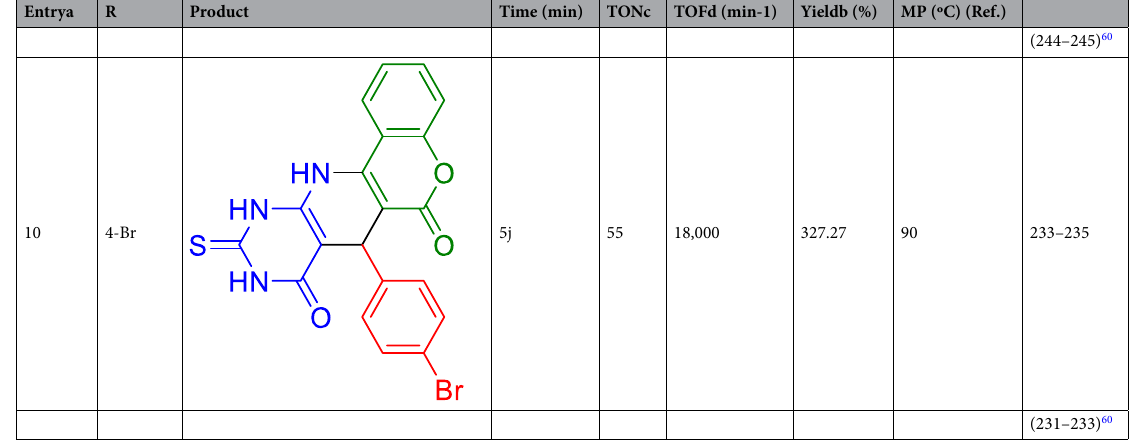
Table 4. NiO NPs-catalyzed the synthesis of pyridopyrimidine derivatives a